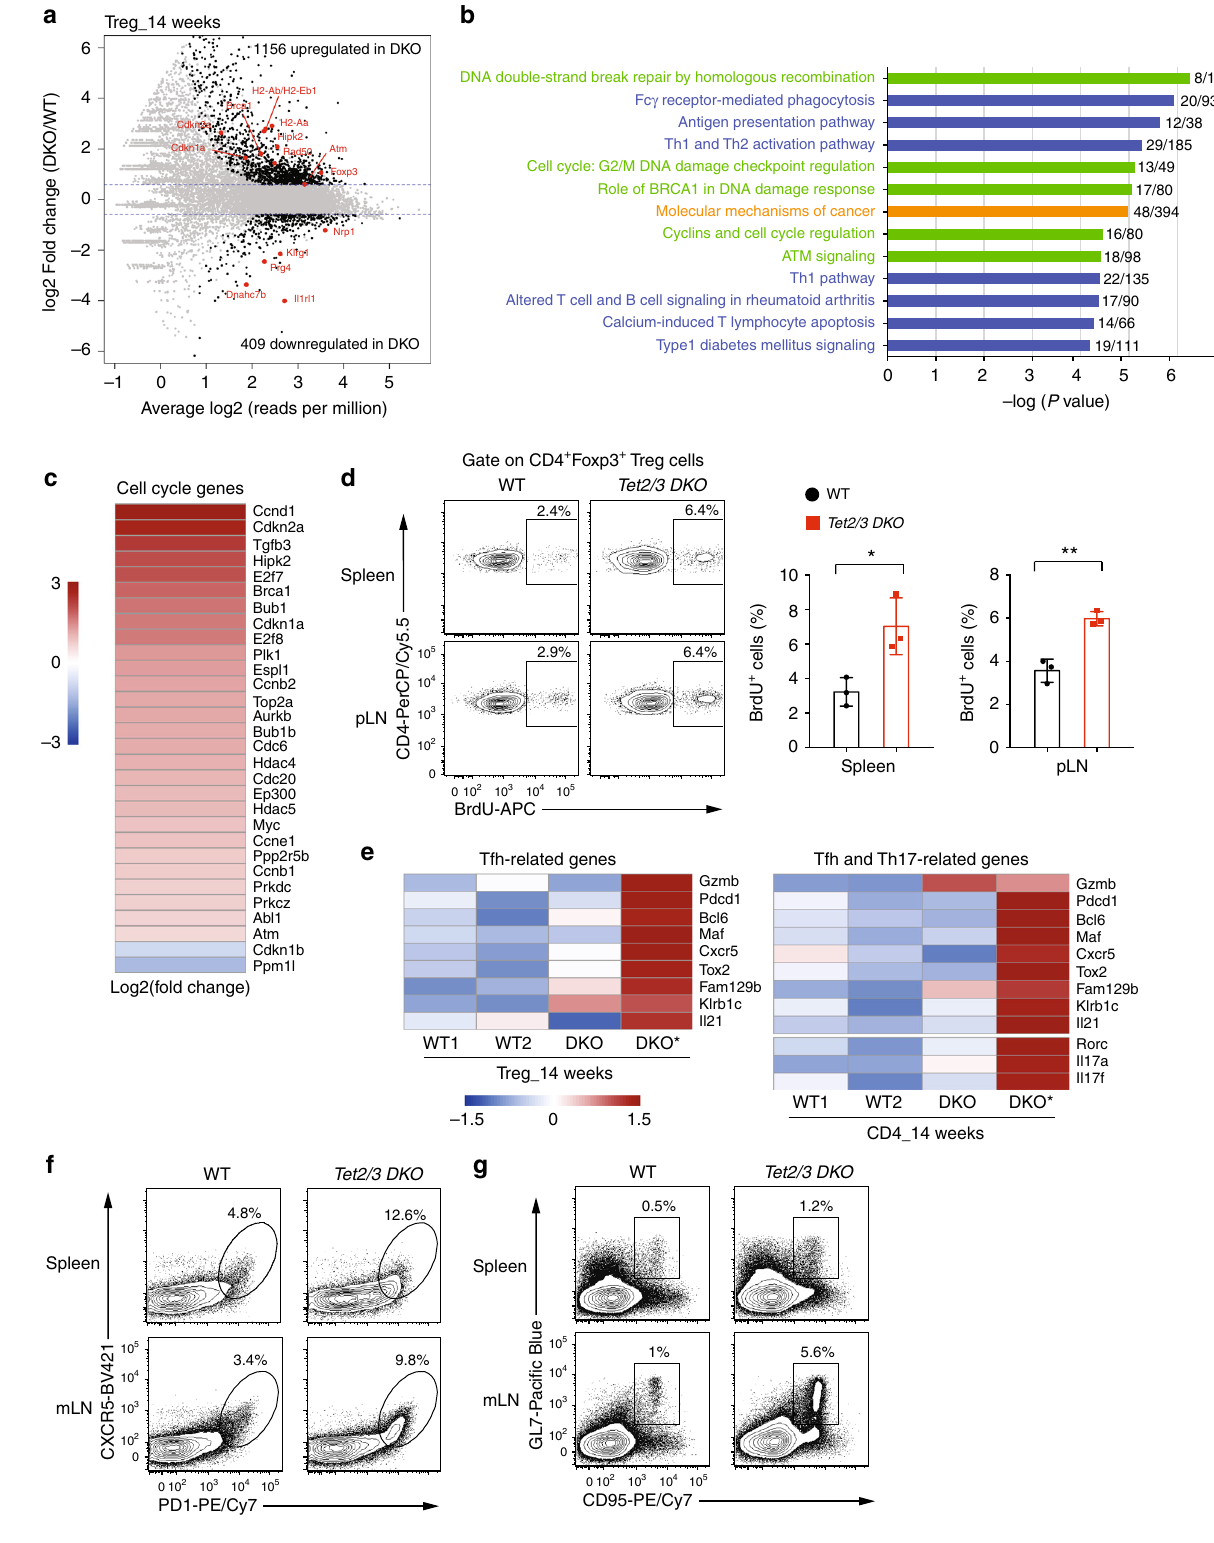
WT Tregs fail to control autoimmunity in Tet -de fi cient mice . Foxp3 is encoded on the X-chromosome, hence due to random X- inactivation, Tet2/3 fl / fl female mice that are heterozygous for Foxp3 Cre ( Foxp3 WT/Cre ) should harbor both Tet2/3 -deleted